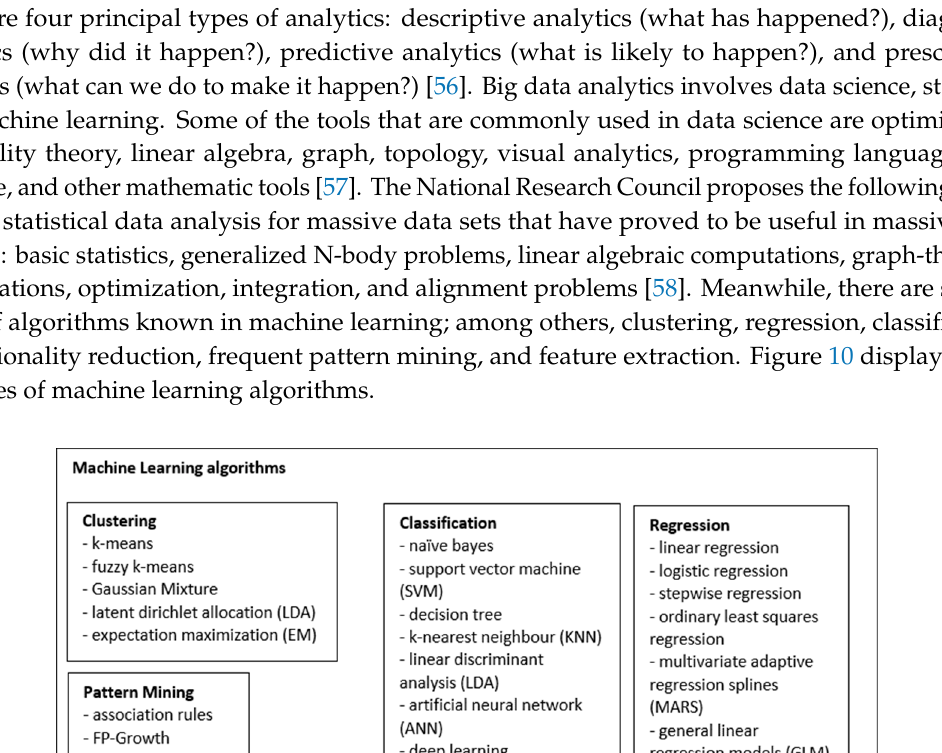
Figure 11. Some components of big data architecture.